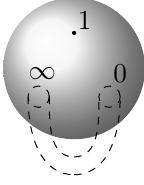
Figure 9 . The plumbing construction for the 1-point torus block.